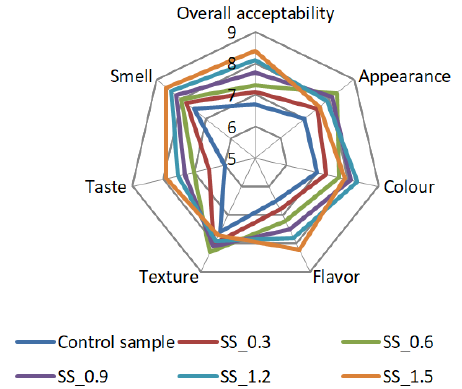
Figure 1. Sensory characteristics of the bread samples.